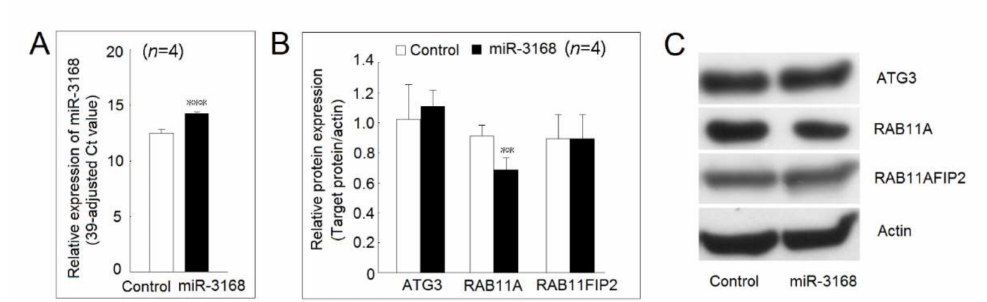
Figure 8. Identification of protein expression regulated by miR-3168. ( A ) The expression of miR- 3168 was markedly increased in U937 after transfection with a miR-3168 mimic compared with those transfected with scrambled oligonucleotides as a control. ( B ) Autophagy-related 3 (ATG3), Ras-related protein Rab-11A (RAB11A), and RAB11 family interacting protein 2 (RAB11FIP2) were potential targets of miR-3168. After transfection of a miR-3168 mimic, the protein expression of RAB11A, but not ATG3 or RAB11FIP2 was decreased in U937 cells. ( C ) A representative example (** p < 0.01; *** p < 0.001).